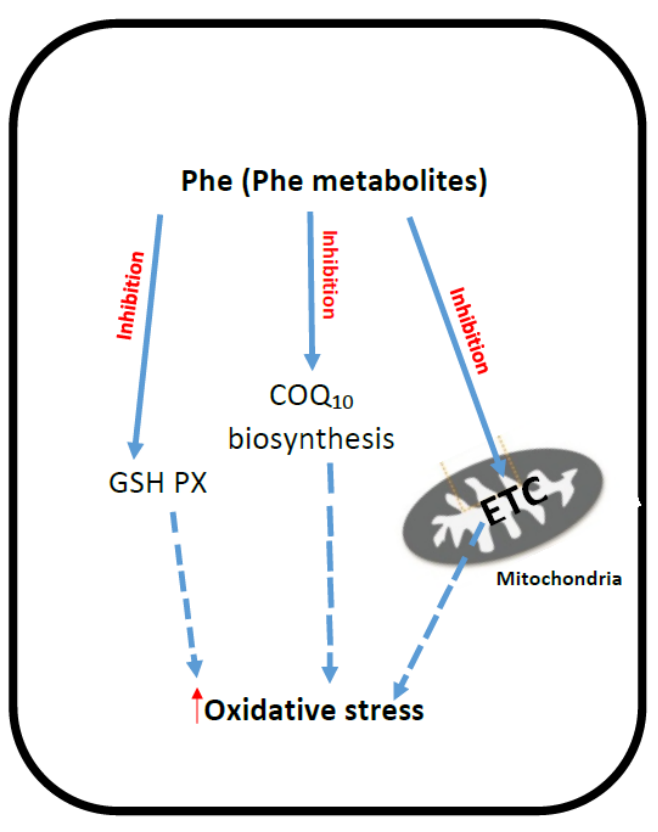
Figure 2. Putative mechanisms of oxidative stress generation and mitochondrial dysfunction in PKU. PKU: Phenylketonuria; Phe: Phenylalanine; ETC: Mitochondrial electron transport chain; CoQ 10 : Coenzyme Q 10 ; GSH ‐ PX: Glutathione peroxidase.